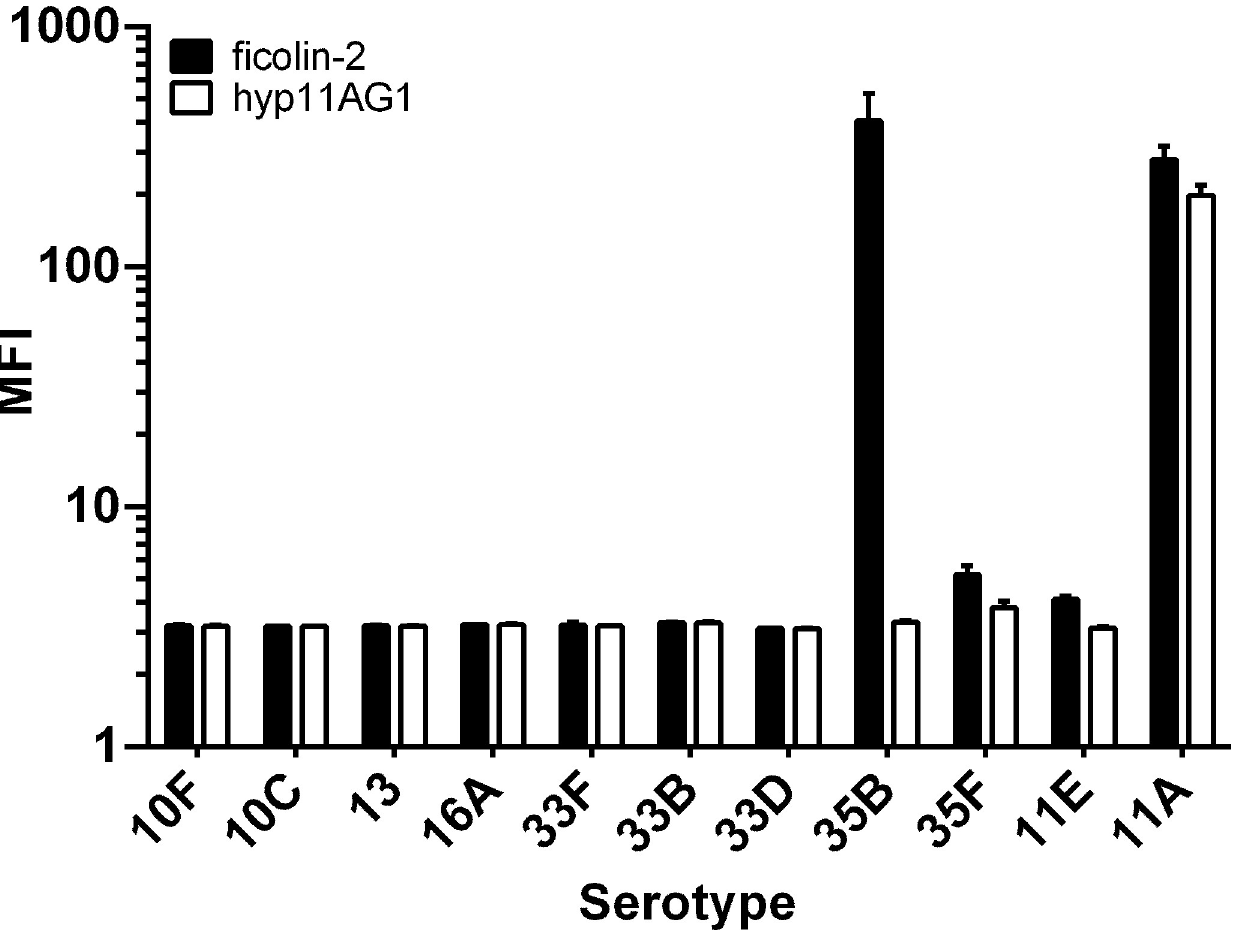
Fig 2. Ficolin-2 does not bind to other wciG -encoding serotypes. Strains of the indicated serotype were incubated with 10% normal human serum for 1 hour and stained with either an anti-ficolin-2 antibody (ficolin-2) or an isotype matched monoclonal antibody specific for the serotype 11A capsule (hyp11AG1) prior to analysis by FACS. Serotypes 11A and 11E served as positive and negative controls, respectively, for both antibodies. Data are presented as mean ± standard deviation of two technical